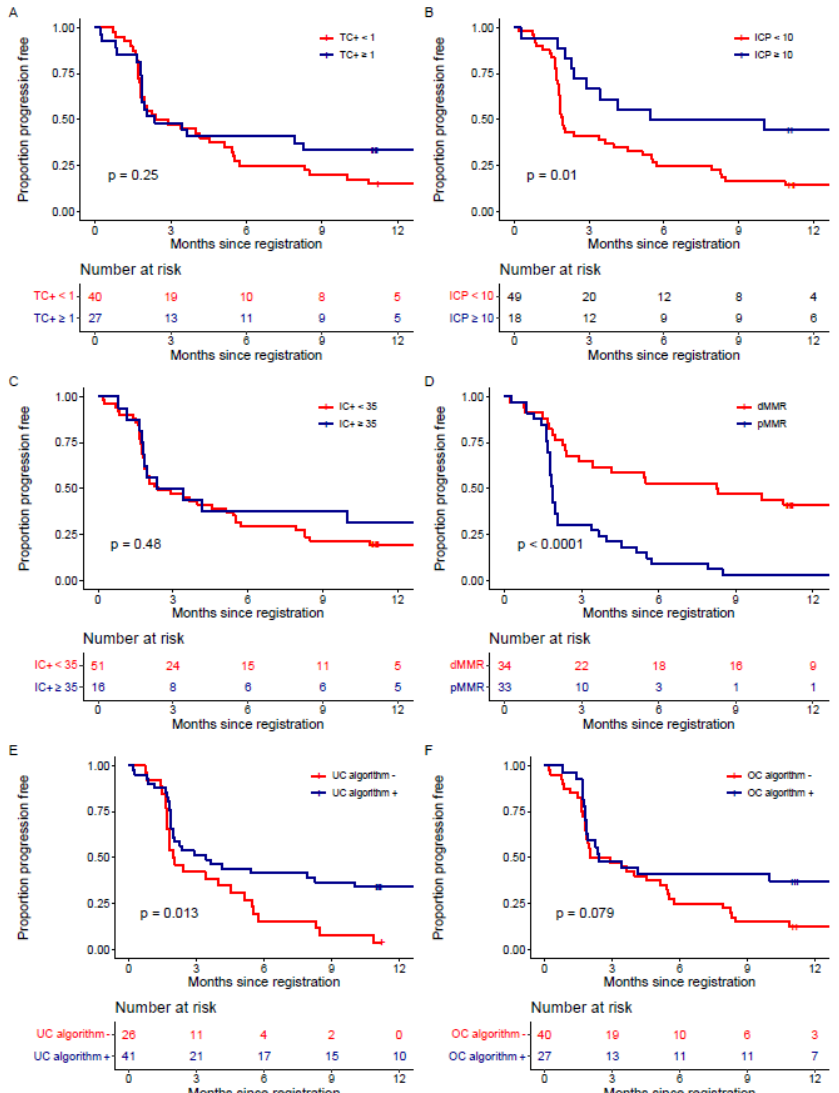
Figure 3. Kaplan – Meier curves for progression-free survival for ( A ) TC+, ( B ) ICP, ( C ) IC+, ( D ) MMR, ( E ) the urothelial cancer (UC) algorithm and ( F ) the optimal cutpoint (OC) algorithm.